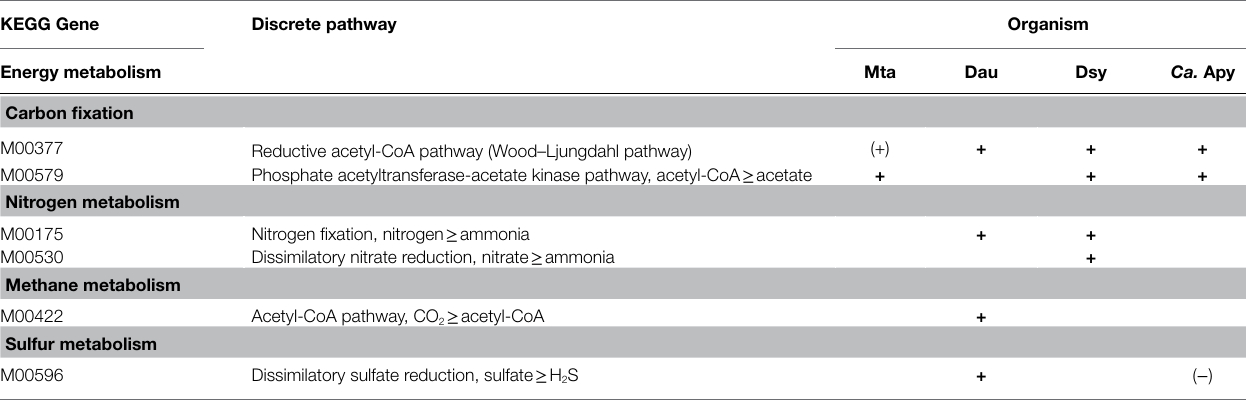
TABLE 2 | Complete pathways of carbon fixation and energy metabolism in Candidatus A. pyornia ( Ca. Apy) and three closely related acetogens as determined by the KEGG pathway module. KEGG Gene Discrete pathway